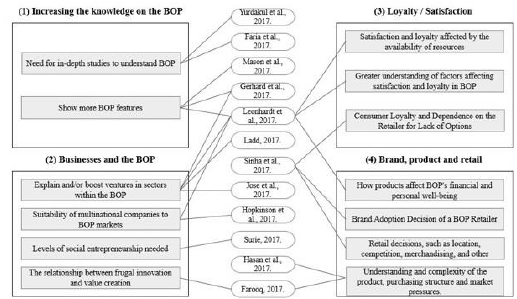
Figure 8. Map of Directions for Future Research on the Bottom of the